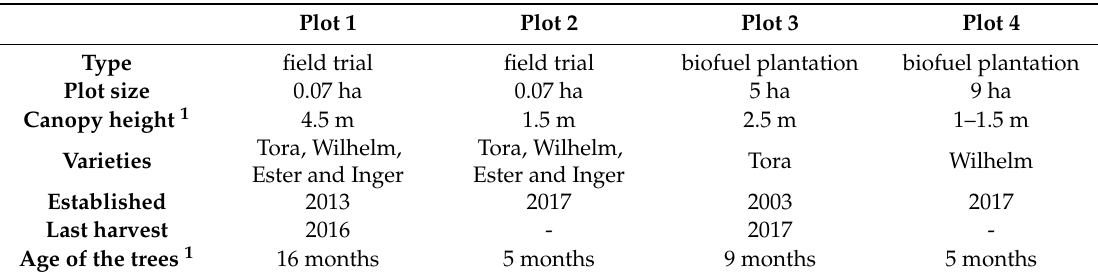
Table 1. The plot type, size (ha), canopy height (m), varieties, establishment, last harvest and age (months) for the trees.